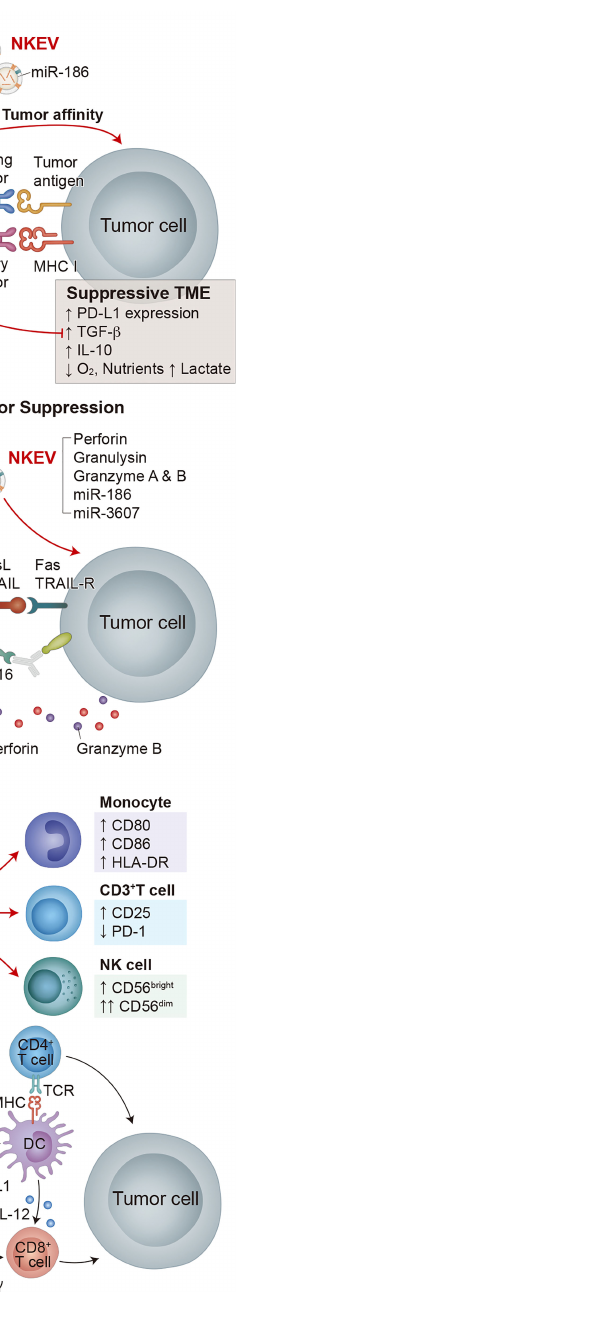
FIGURE 1 | Functions of NK cells and NKEVs. The key functions of NK cells are immune surveillance, cytotoxicity and tumor suppression, and immune modulation, all of which involve both NK cells and NKEVs. (A) NK cell immune surveillance depends on the interaction of activating and inhibitory receptors with target cells. In suppressive TMEs, NK cells are inhibited by PD-L1 on tumor cells and tumor cell-secreted TGF- b and IL-10. Decreased oxygen concentration, increased lactate production, and decreased available nutrients also inhibit NK cells. NKEVs exhibit tumor af fi nity, and NKEV delivery of miR-186 to NK cells decreases TGFBR1/2 expression, fortifying them in suppressive TMEs. (B) Cytotoxicity and tumor suppression by NK cells depends on either CD16 regulated ADCC or degranulation of vesicles containing perforin and granzyme B in response to the combined activation of activating receptors. NKEVs directly deliver cytotoxic effector cargo of perforin, granulysin, granzyme A and B, as well as miRNAs miR-186 and miR-3607 to tumor cells. (C) NK cells produce immunomodulatory cytokines and chemokines in response to activation, directly activating CD8 + T cells, and stimulating dendritic cells to activate both CD8 + and CD4 + T cells, which subsequently attack tumors. Meanwhile, NKEVs increase CD80, CD86 and HLA-DR expression on monocytes, increase CD25 expression and decrease PD-1 expression on CD3 + T cells, and increase the total NK cell population and the CD56 dim NK cell